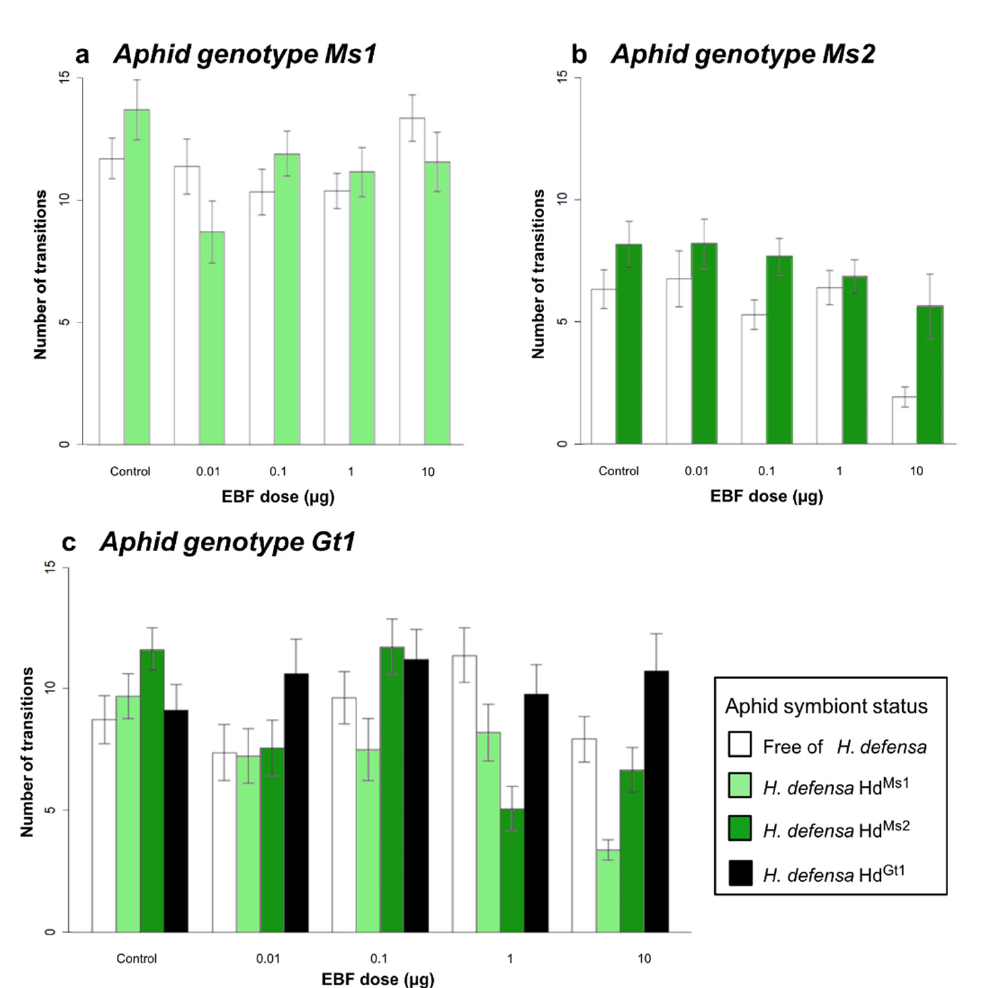
Figure 3. Number of transitions in the olfactometer at different EBF doses in A. pisum genotypes carrying or not carrying H. defensa. White bars represent lines without H. defensa , and coloured bars represent lines with H. defensa . Different colours refer to different H. defensa strains. ( a ) Aphid genotype Ms1 (specialised on M. sativa ). ( b ) Aphid genotype Ms2 (specialised on M. sativa ). ( c ) Aphid genotype Gt1 (specialised on G. tinctoria ). Error bars show the standard error. N = 30 aphids for each stimulus and line.